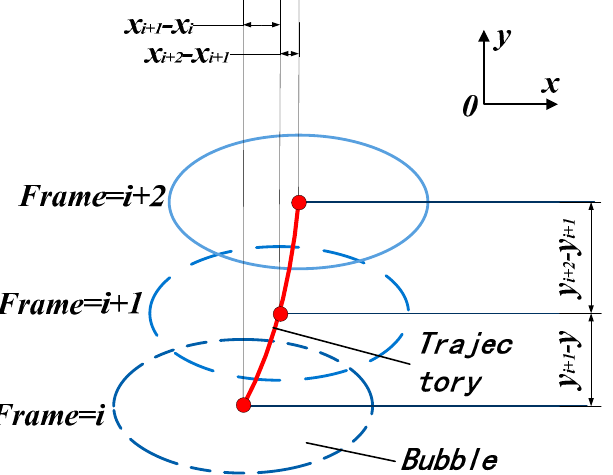
Figure 5. Bubble parameter calculation method.